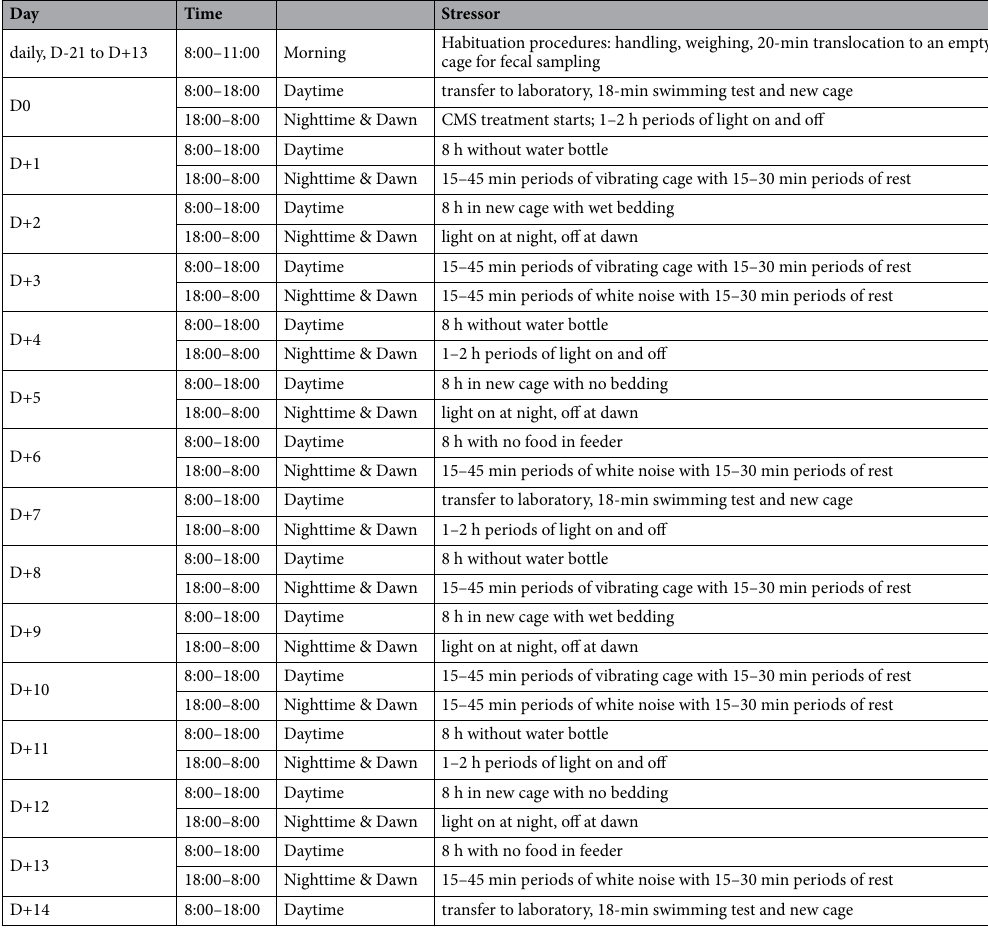
daytime usually started immediately after these daily